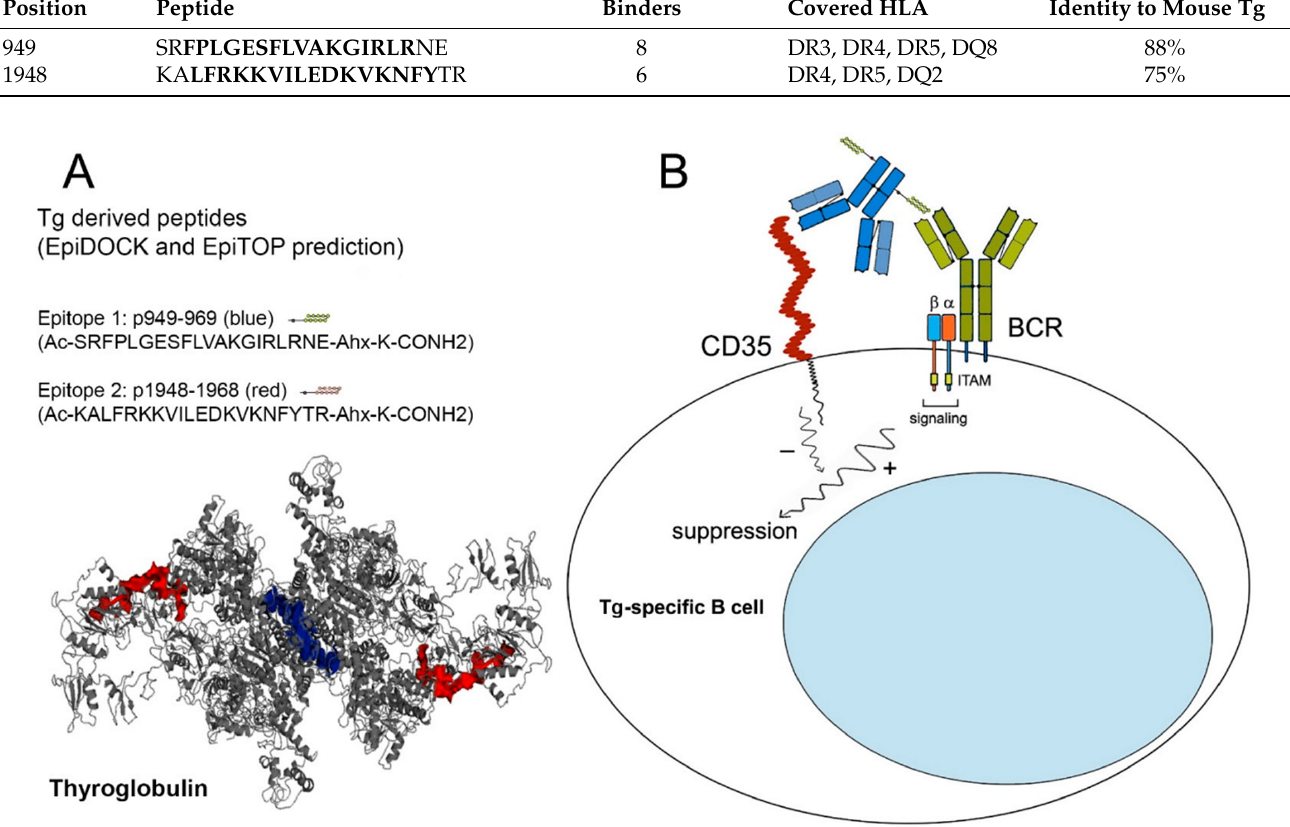
Figure 1. The generated Tg chimeras suppress selectively disease-associated Tg-specific B cells by crosslinking the BCR and CD35 on the cell surface. ( A ) Structure of human Tg dimer (pdb code: 6SCJ). Epitope 1 (p949-969) is shown in blue. Epitope 2 (p1948-1968) is shown in red. The image was generated by PyMOL Molecular Graphics System, version 2.5.0. ( B ) The co-crosslinking of Tg-specific BCR and the inhibitory CR1 receptor on pathological autoreactive B lymphocytes generates negative signal transduction for B-cell Table 1. Human Tg peptide fragments selected in the present study. The predicted binding cores are given in bold.